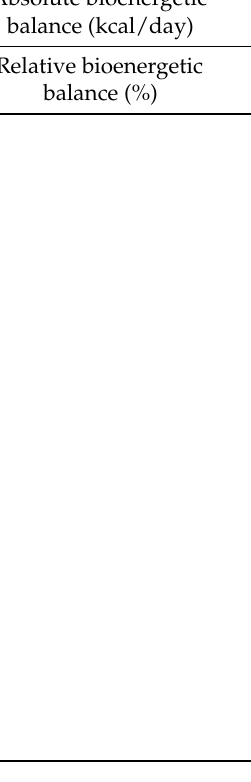
Table 3. Absolute and relative bioenergetic balances during the different Continuous venovenous hemofiltration (CVVH) settings. Low Dose CVVH High Dose CVVH Low Dose CVVH with Citrate with Citrate without Citrate